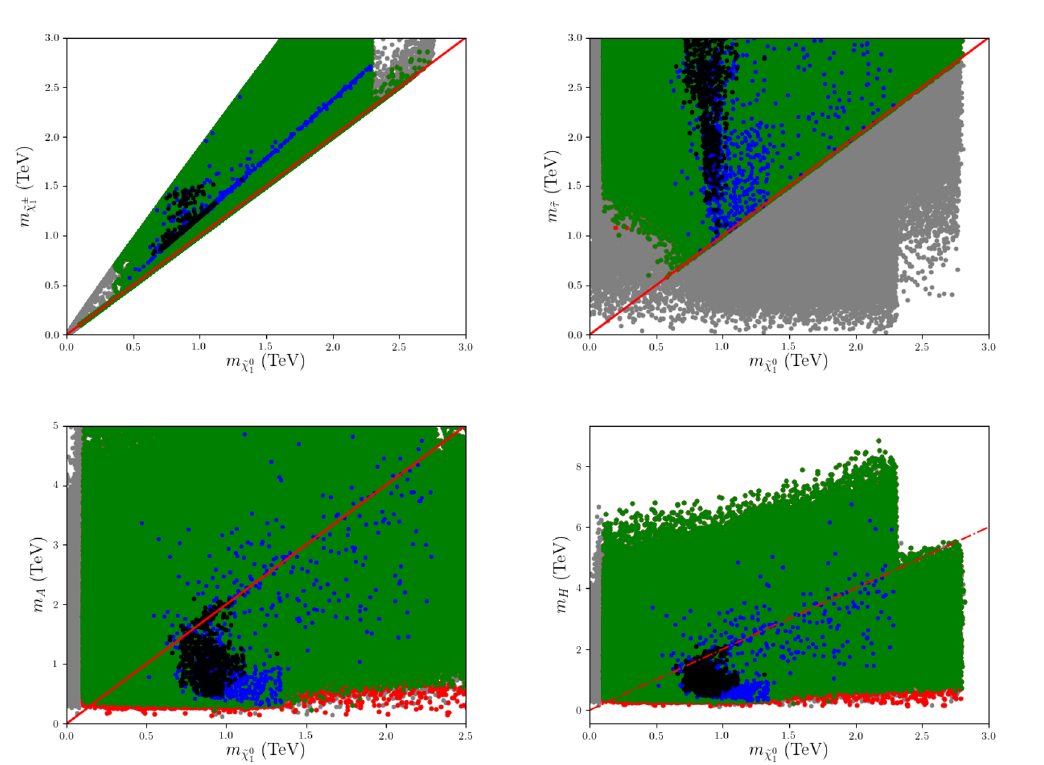
Figure 3 . The mass spectrum of SUSY states over the following planes: ( m ˜ ( m ) (right). Our colour convention is as listed at the end of section 3. ˜ ν , m ˜ τ